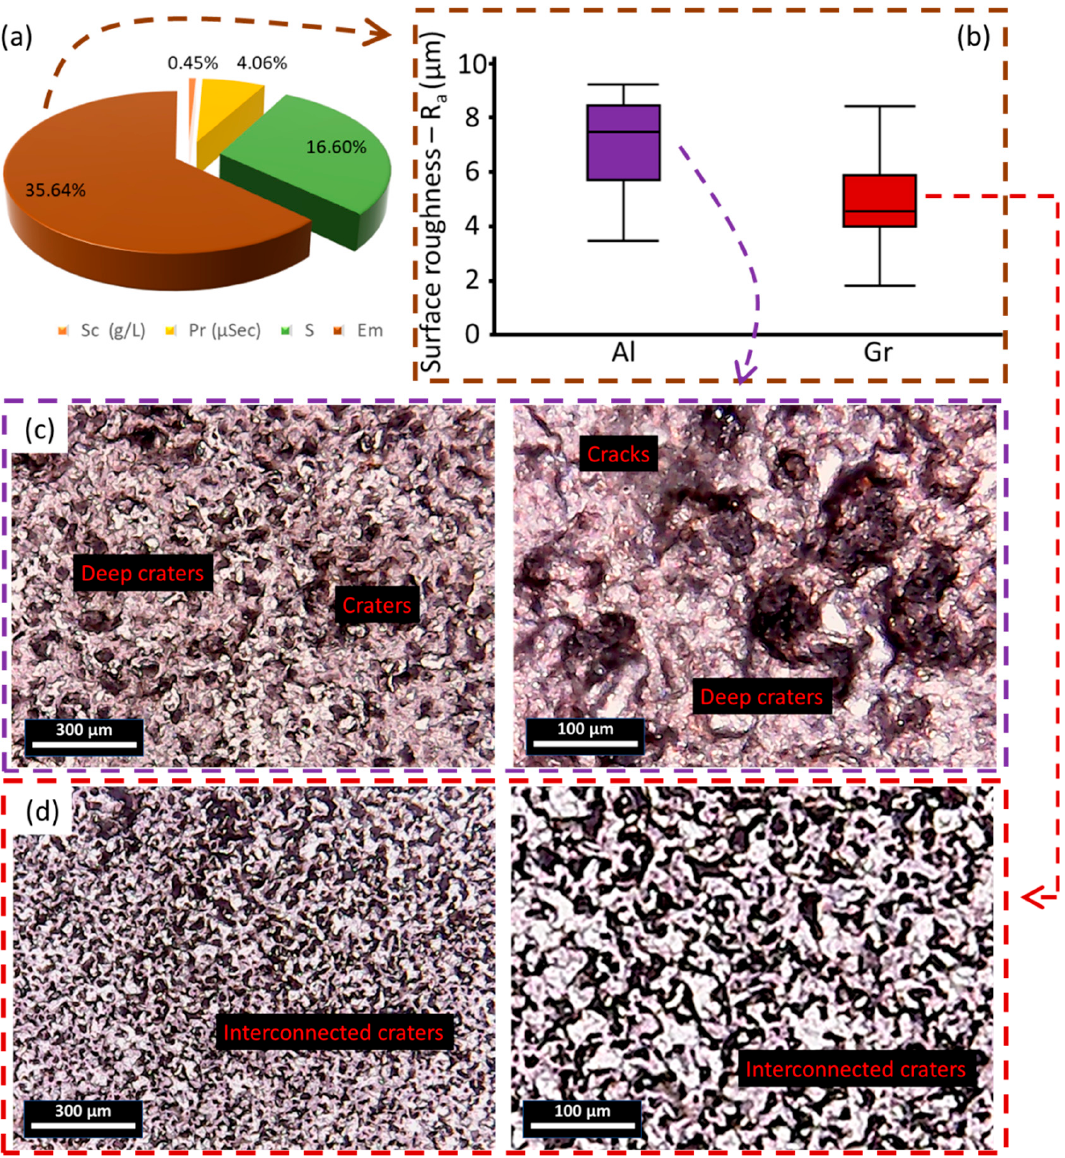
Figure 6. Tool electrode analysis during modified process; ( a ) percentage contribution for controlling modified process; ( b ) effect of tool electrode material; ( c ) micrograph of kerosene with 12.5 g/L of S-60 using Al electrode; ( d ) micrograph of kerosene with 12.5 g/L of S-60 using Gr electrode.